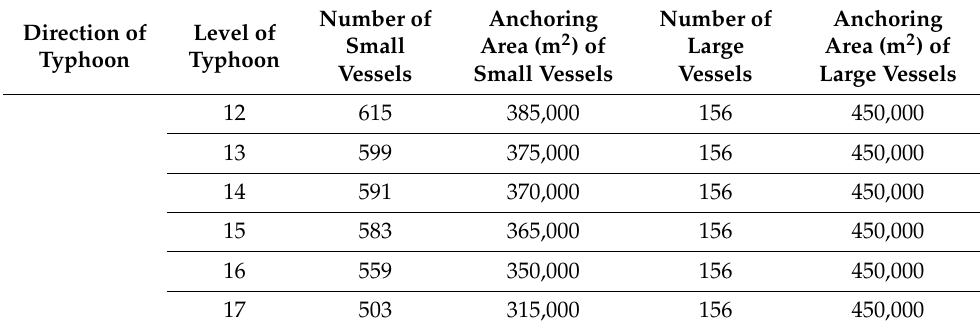
Table 3. Number of accommodated fishing vessels in SYFP under different levels of typhoons (multiple vessels abreast with a single